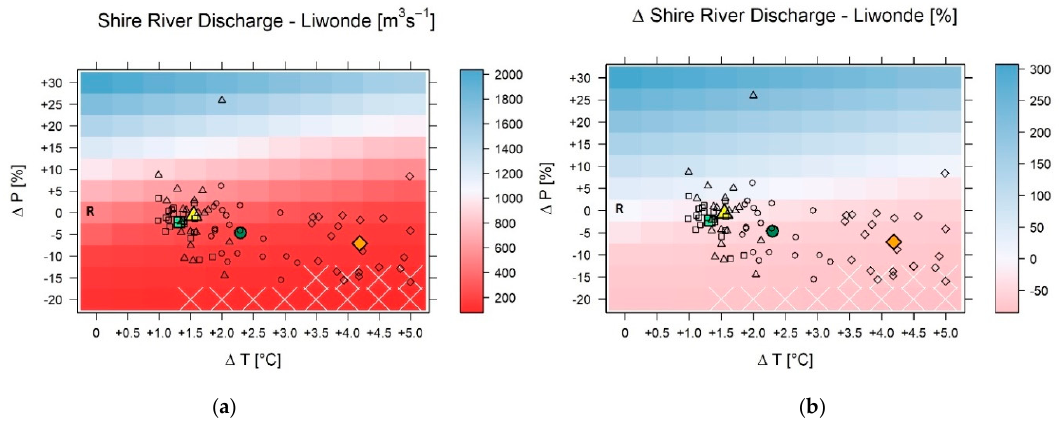
Figure 9. Same as Figure 8 but for mean discharge at Liwonde gauge generated with systematically perturbed meteorological observation data as input to the hydrological model chain. Absolute (in m³/s, left ) and relative (in % deviation from reference mean discharge, right ) mean changes.